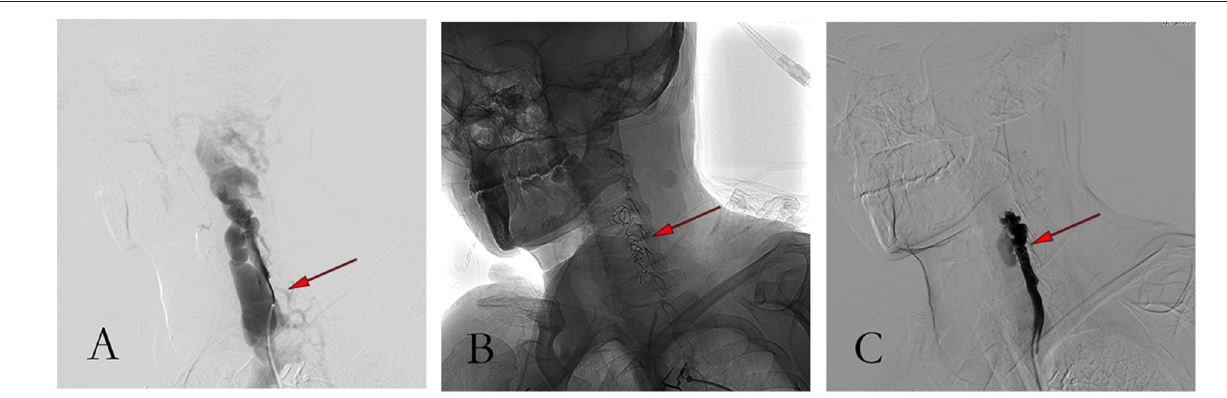
Frontiers in Neurology |